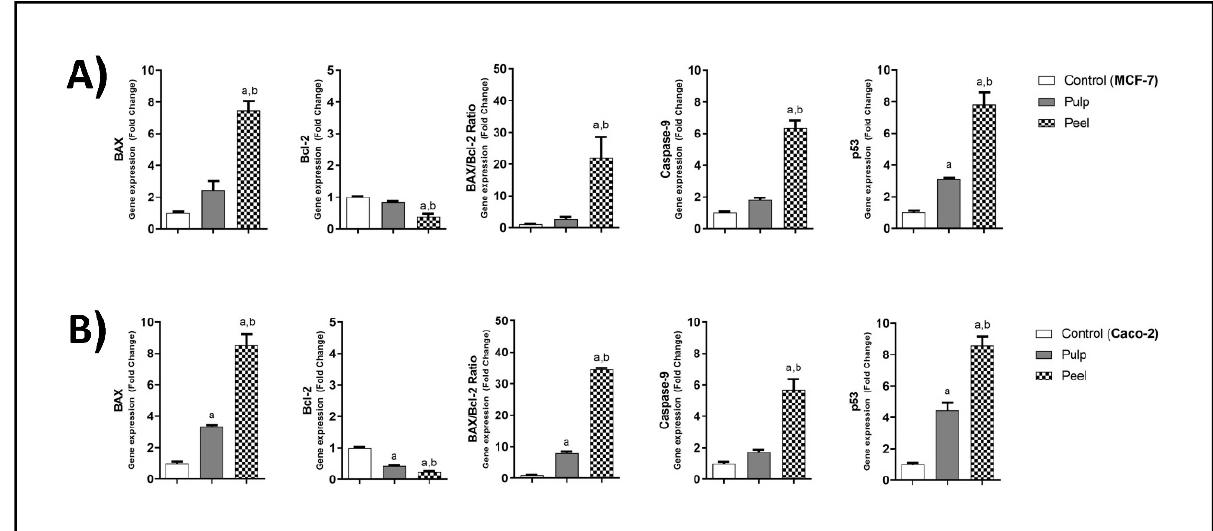
Figure 3. Gene-expression analysis of BAX, Bcl-2, caspase-9, and p53 after treatment with IC 50 of H. undatus pulp and peel extracts for 48 h of ( A ) MCF-7 and ( B ) Caco-2 cells. Cells were seeded in T-25 cm 2 tissue culture flasks for 24 h before treatment with DMSO or with pulp or peel extracts for 48 h. Total RNA was extracted, reverse-transcribed, and assayed for BAX, Bcl-2, Caspase-9, and p53 gene expression by quantitative reverse-transcription PCR. GAPDH was used as the housekeeping gene. Data from at least three independent experiments are presented as a ratio of the target gene/GAPDH expression (relative mRNA levels) and are represented as the mean ± SEM. Normalized data are expressed as fold changes, with the control set to “1.” a: Significantly different from the corresponding control group at p < 0.05. b: Significantly different from the pulp extract-treated group at p < 0.05. Multiple comparisons were accomplished using one-way ANOVA followed by Tukey–Kramer analysis as a post-ANOVA test.